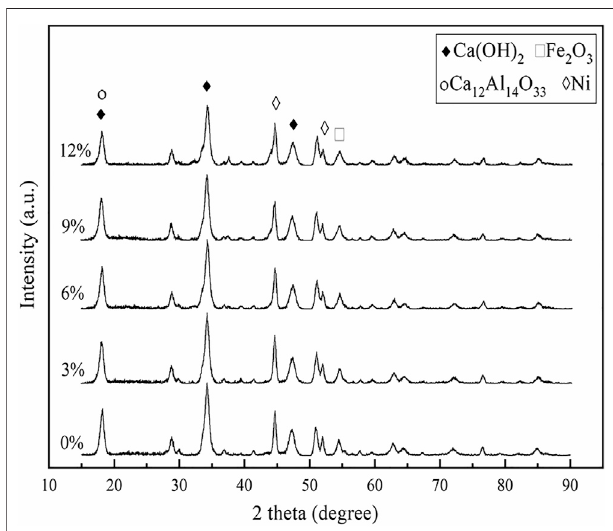
FIGURE 9 | XRD patterns of Fe-modi fi ed catalysts with different doping mass proportions.